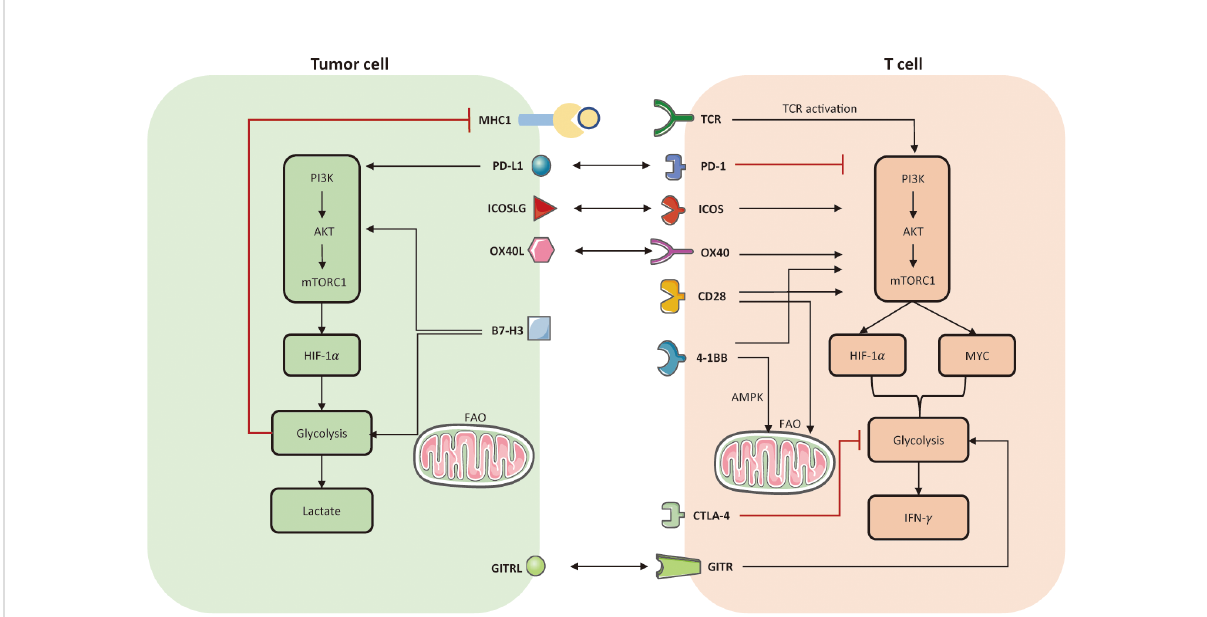
FIGURE 3 Metabolic modulation of immune checkpoints and their ligands. Activation of TCR and co-stimulatory molecules respectively provides signal 1 and 2 to activate T cell anti-tumor function, referring to the establishment of PI3K-AKT-mTOR, HIF-1 a , MYC. In tumor cells, PD-L1 and B7-H3 could activate aerobic glycolysis via activating PI3K-AKT-mTORC1 pathway. But the enhanced glycolysis limits the expression of MHC-I molecule on tumor cell surface, which may induce immune escape. In T cells, both PD-1 and CTLA-4 signaling impair glycolysis. The difference is that, PD-1 also prompts FAO but CTLA-4 has no effect on FAO. Co-stimulation receptors, such as ICOS, OX-40, CD-28, 4-1BB, all facilitate glycolysis in T cells by activating PI3K-AKT-mTORC1. Notably, 4-1BB is able to enhance mitochondrial activity in CD8 + TILs as well. Another